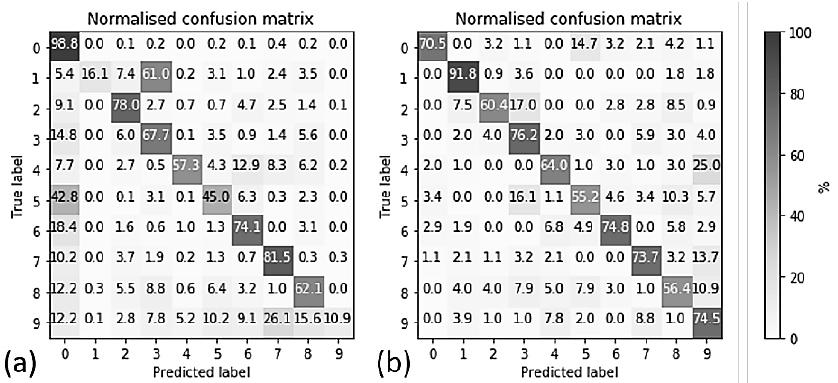
Figure 6. Normalized confusion matrices showing the classification results for the case that the drifting wavelength is: ( a ) not part of the training set and; ( b ) is included in the drifting wavelengths for which the VGG classifier is trained.